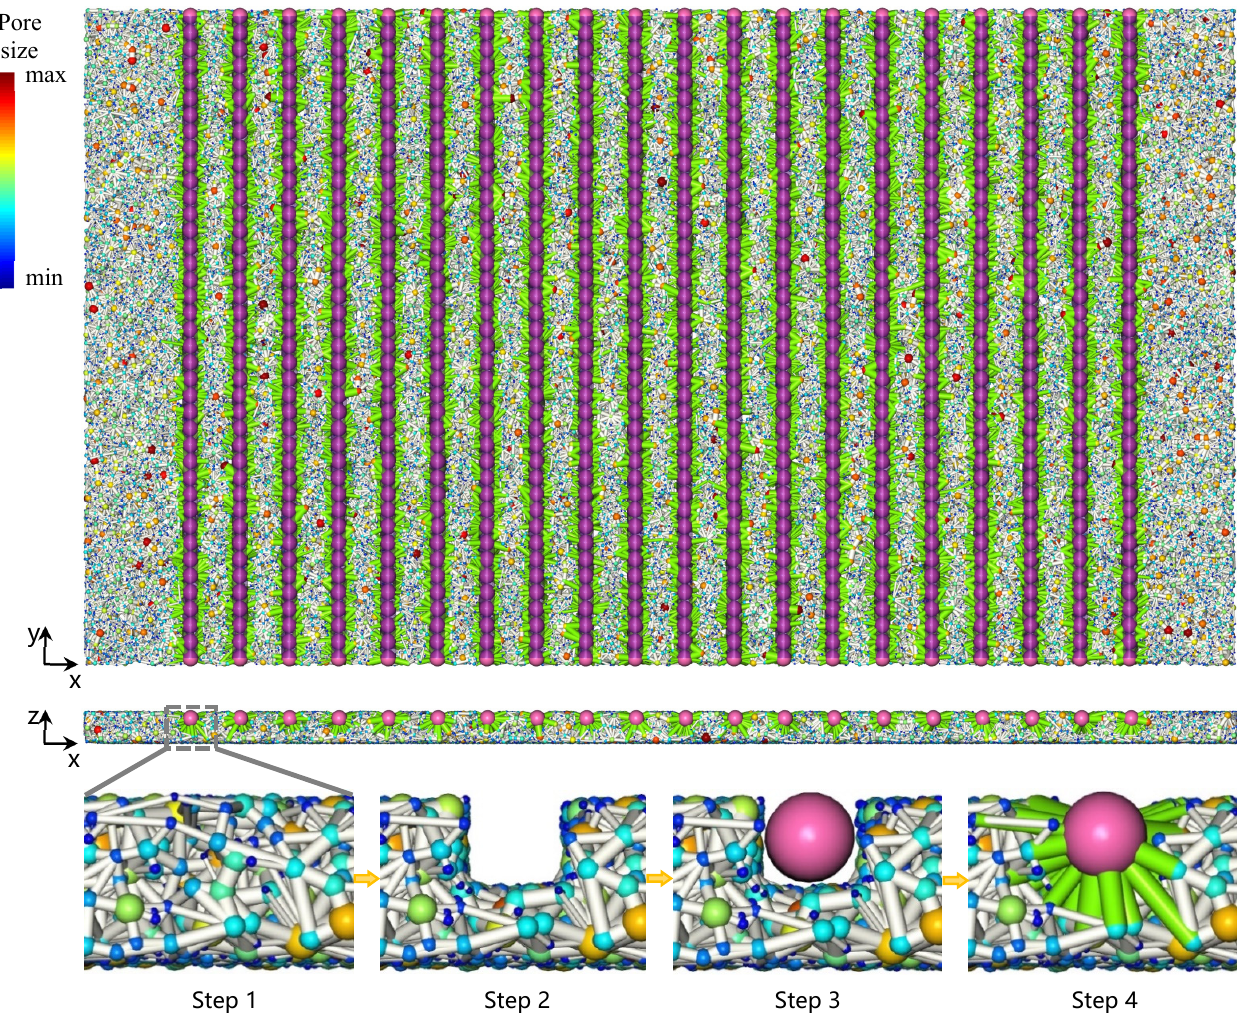
Figure 8. Stochastic pore network modeling of 80% porosity porous fibrous material with microchannels. Step 1: the initial 80% porosity stochastic network. Step 2: dig out elements in the microchannels, the hanging throats are not shown. Step 3: add channel pore chains shown in purple. Step 4: generate channel throat between adjacent channel pores shown in transparent purple to avoid covering the channel pore, the hanging throat is reconnected as being shown in